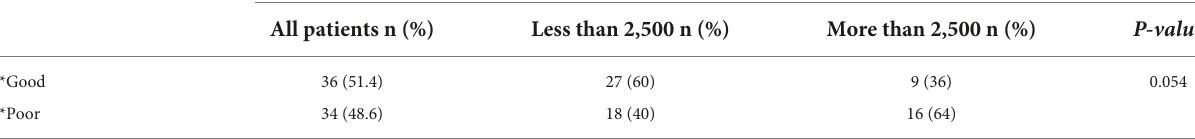
TABLE 4 Association of level of adherence toward iron chelation with serum ferritin level. Level of